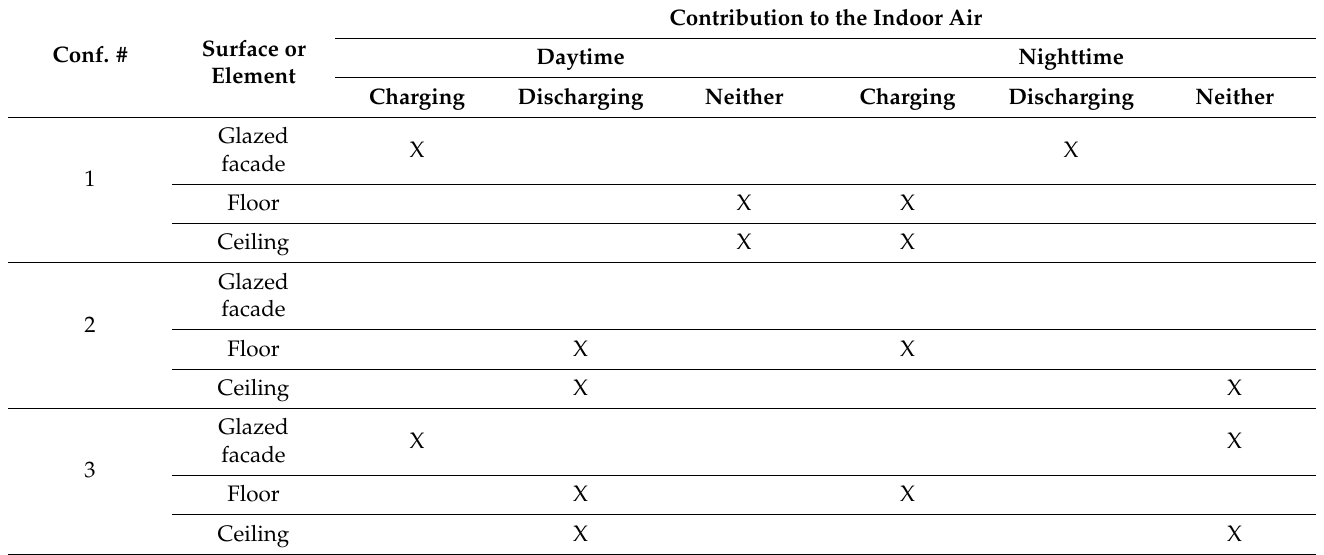
Table 7. Contribution of different surfaces to the indoor air based on convective heat